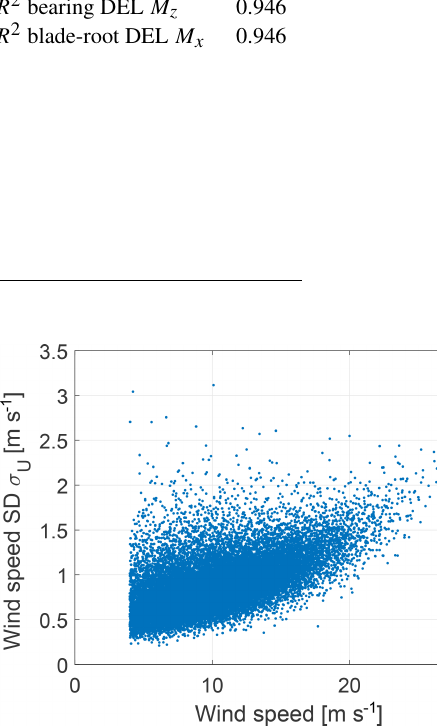
Figure 12. Sampled wind speed standard deviation taken from SCADA.